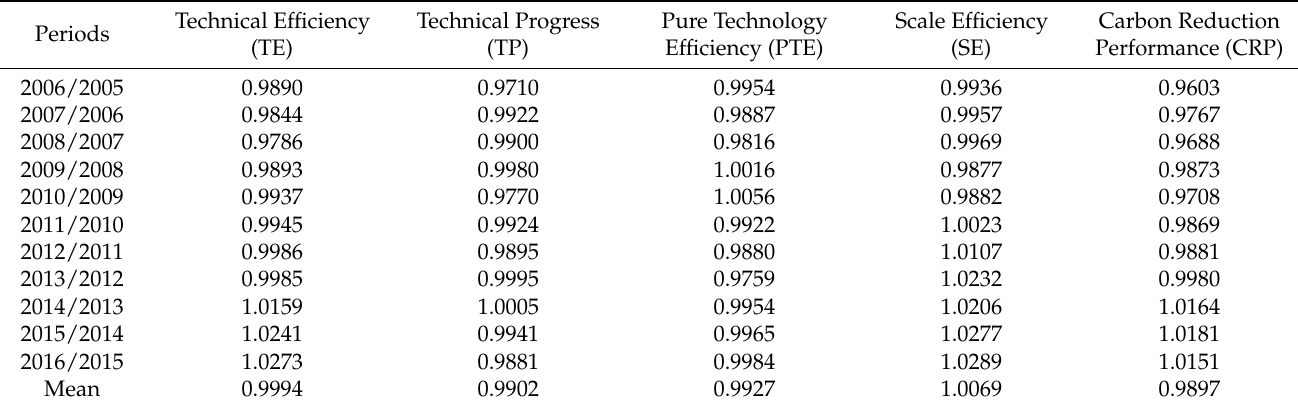
Table 2. Carbon reduction and contributors’ performance during 2005–2016.